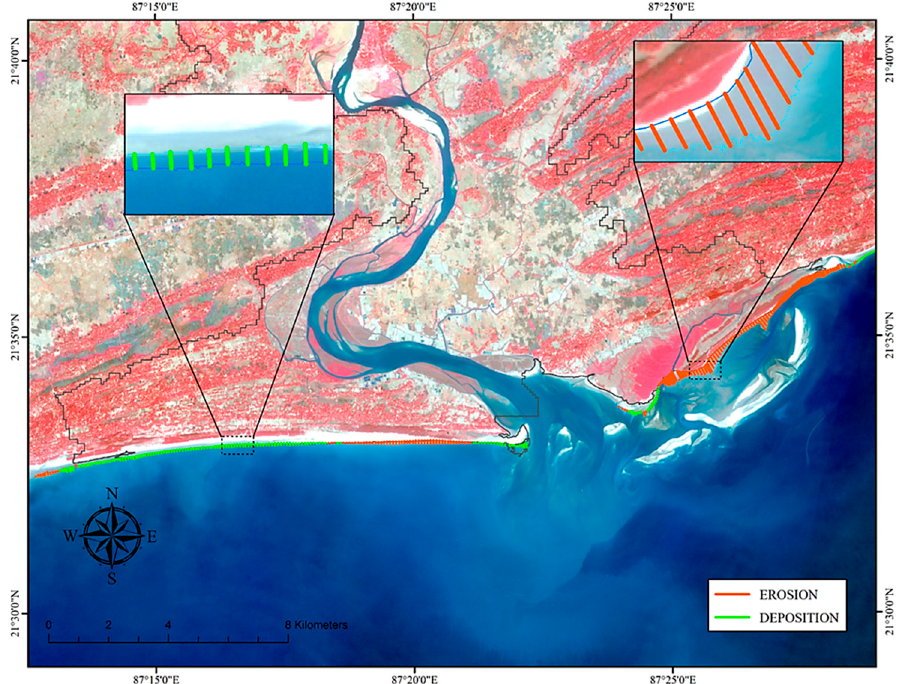
Figure 15. Geospatial output illustration of the Erosion-Accretion scenario (2017–2021) of the Sub- arnarekha’s estuarine section (Digha